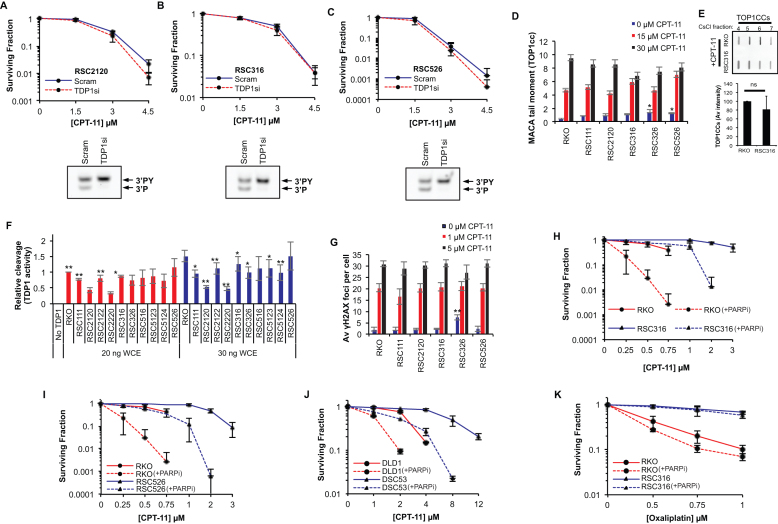
PARP1/TDP1 axis does not underpin irinotecan resistance in CRC cells. Irinotecan-resistant RSC2120 (A, upper panel), RSC316 (B, upper panel) and RSC526 (C, upper panel) were treated with a scrambled siRNA or a pool of four TDP1 siRNA sequences followed by treatment with the indicated concentrations of irinotecan. Survival was calculated from three biological replicates ± STD. Lysates prepared from the corresponding TDP1-depleted cells were subjected to a TDP1 activity assay and reaction products separated by 20% denaturing PAGE (A–C, lower panels). The substrate (3΄PY) and product (3΄P) are indicated for one representative experiment of three. (D) Parental RKO and RKO derived irinotecan-resistant cells were treated with irinotecan for 1 h and TOP1 cleavage complexes (TOP1cc) quantified by the modified alkaline comet assay. The average tail moment of three biological replicates is shown ± STD for 100 cells measured per sample. (E) Cells were treated with irinotecan and TOP1cc purified by CsCl fractionation followed by immunoblotting using anti TOP1 antibodies. CsCl fractions enriched with TOP1cc (fractions 4–7) are shown from a representative experiment (top) and the average intensity of TOP1cc ± STD from three biological replicates is shown (bottom). (F) Whole cell extract prepared from RKO derived irinotecan resistant clones were incubated with oligonucleotides harbouring a 3΄-phosphotyrosine modification (3΄PY) and 5΄-fluorophore to monitor TDP1 catalytic activity. Reaction products were separated by 20% denaturing PAGE and imaged using a FujiFilm Fluor Imager FLA-5100 at 635 nm. TDP1 catalytic activity was quantified as % cleavage of 3΄PY to 3΄P and data are the average of three biological replicates ± STD. (G) The indicated cells were treated with DMSO, 1 μM or 5 μM CPT-11 for 1.5 h and left to recover for 2 h prior to fixing, permeabilising and immunostaining with a γH2AX primary antibody (JBW301, Millipore) and a FITC-labeled secondary antibody. γH2AX foci were counted for 36 cells per sample on a Nikon Eclipse e-400 microscope and the average number of γH2AX foci per cell for three independent experiments is shown ± STD. The RKO cell line and resistant clones RSC316 (H) and RSC526 (I) as well as the DLD1 cell line and resistant clone DSC53 (J) were subjected to an irinotecan survival assay in the presence and absence of 1 μM olaparib (PARP inhibitor). The cells were pre-treated with olaparib for 1 h prior to addition of indicated amounts of CPT-11, both left in for the duration of colony formation. The colonies were fixed, stained and counted and presented as the average surviving fraction for three independent experiments ± STD. (K) Similarly, the RKO and RSC316 cell lines were subjected to an oxaliplatin survival assay in the presence and absence of 1 μM olaparib. The surviving fraction is shown for the average of three independent experiments ± STD.